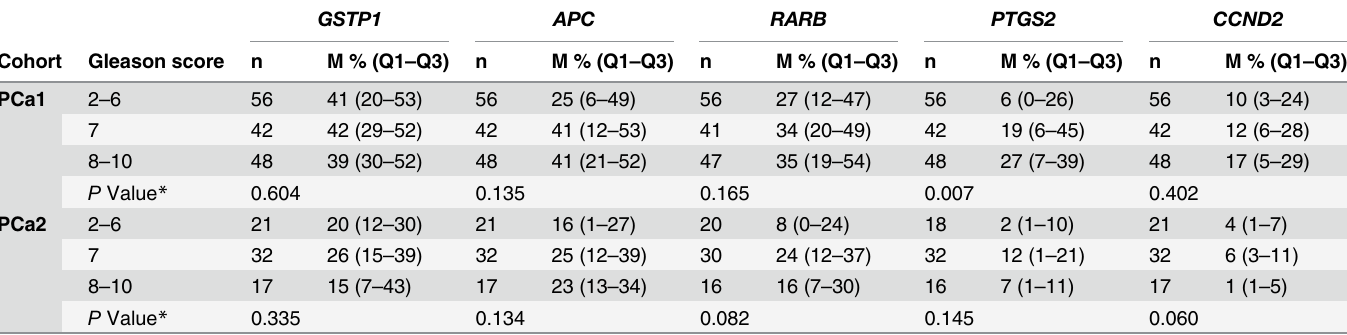
Table 3. Correlation analysis of DNA methylation and Gleason